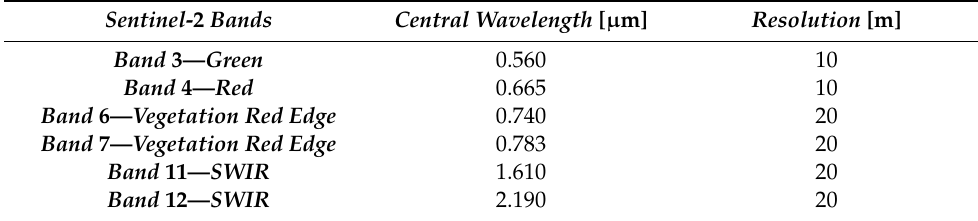
Table 3. Bands chosen for the composition of Sentinel-2